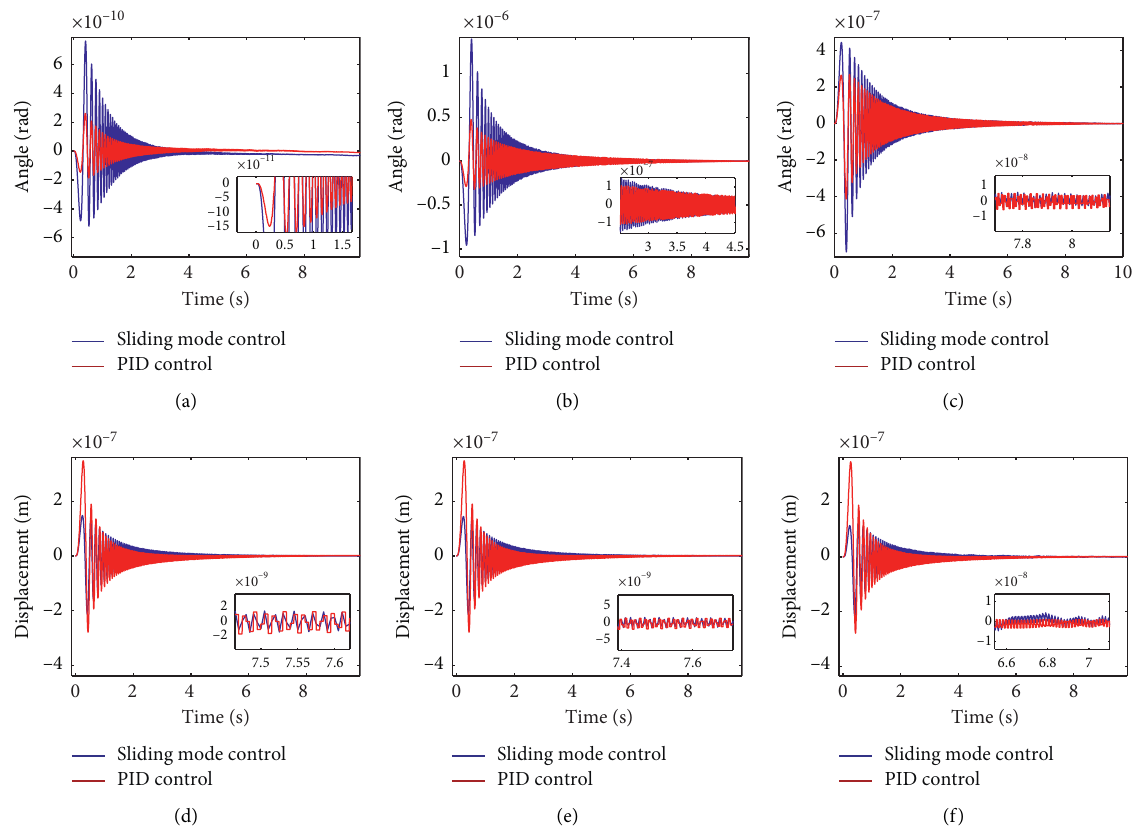
Figure 16: Changes in floating platform position and posture under sweep disturbance: (a) θ